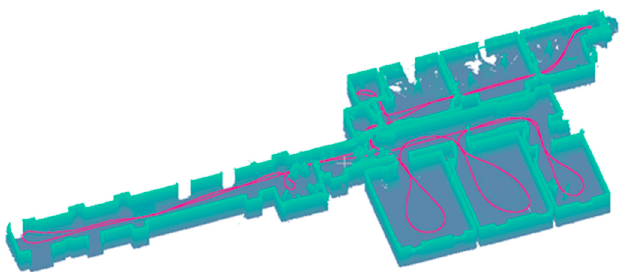
Figure 10. The data set provided by the ISPRS Scientific Initiative on Indoor modelling used as case study.